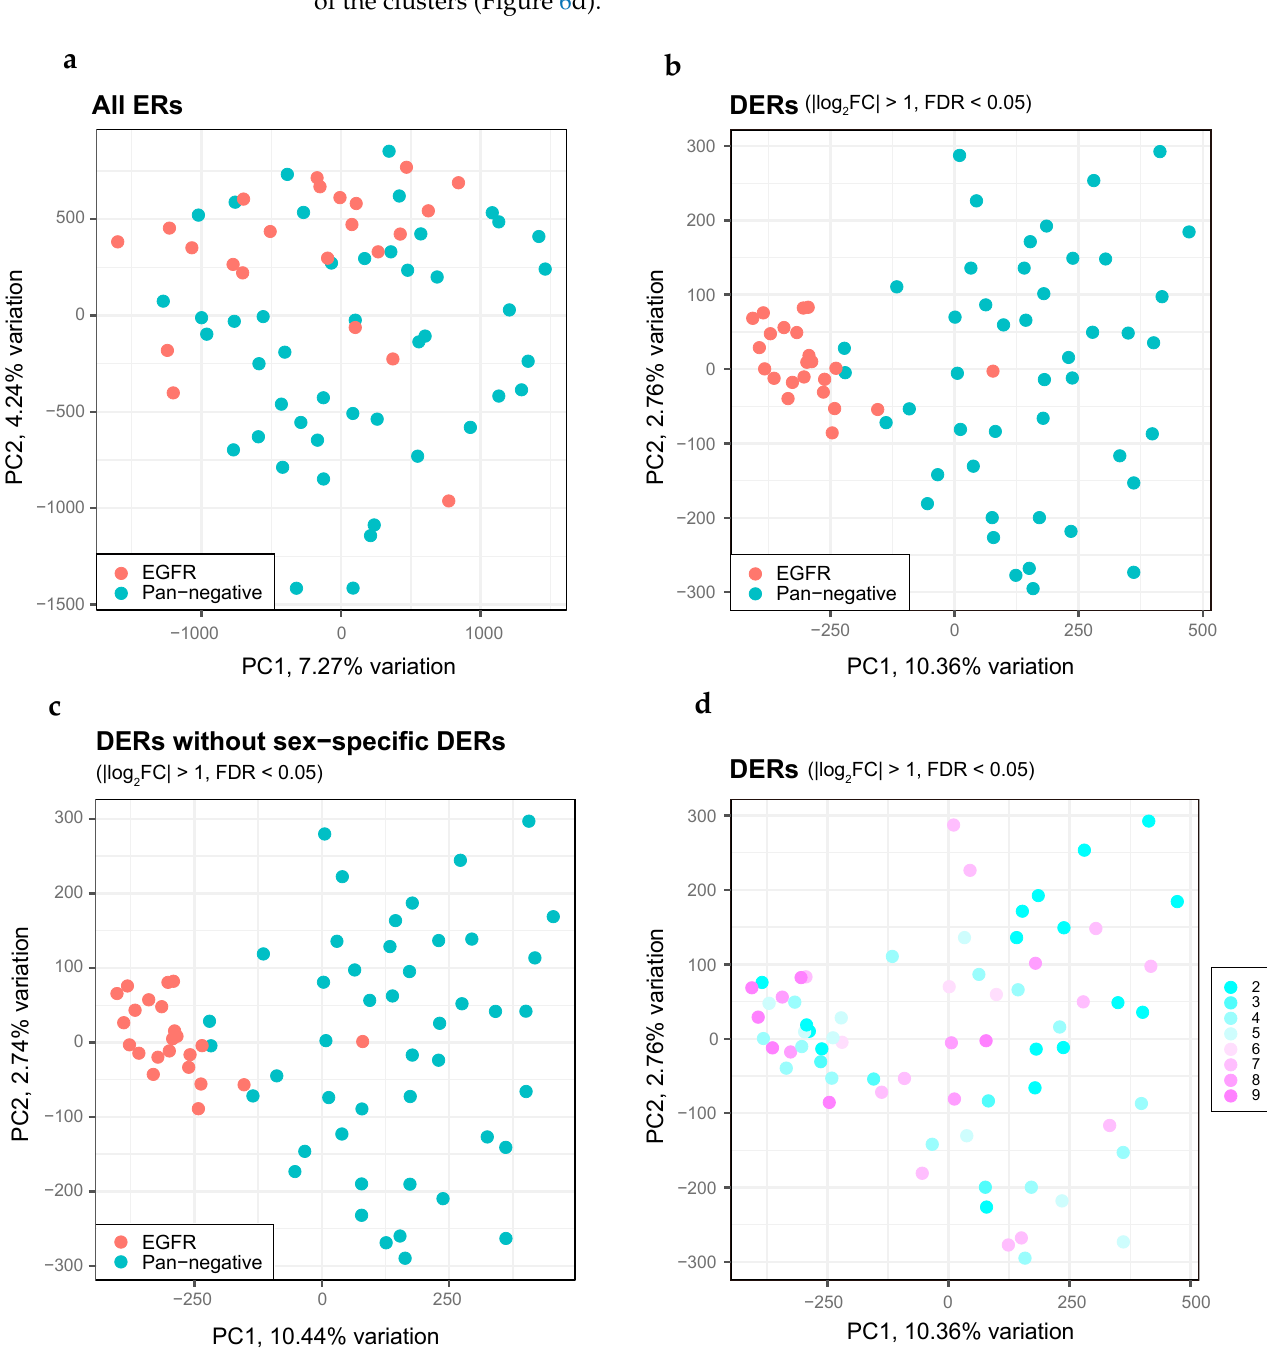
Figure 6. Distinct features of DERs between EGFR-mutant and pan-negative LUADs obtained by H3K27ac ChIP-seq. ( a ) PCA plots for all ERs, comparing EGFR-mutant (red dots, n = 23) and pan-negative (blue dots, n = 46) LUADs. ( b ) The same as panel ( a ) but showing PCA plots for DERs. ( c ) The same as panel ( b ) but we excluded DERs on the sex chromosomes. ( d ) The same as panel ( b ) but we highlighted the elapsed time (years) of each FFPE tissue in colors.